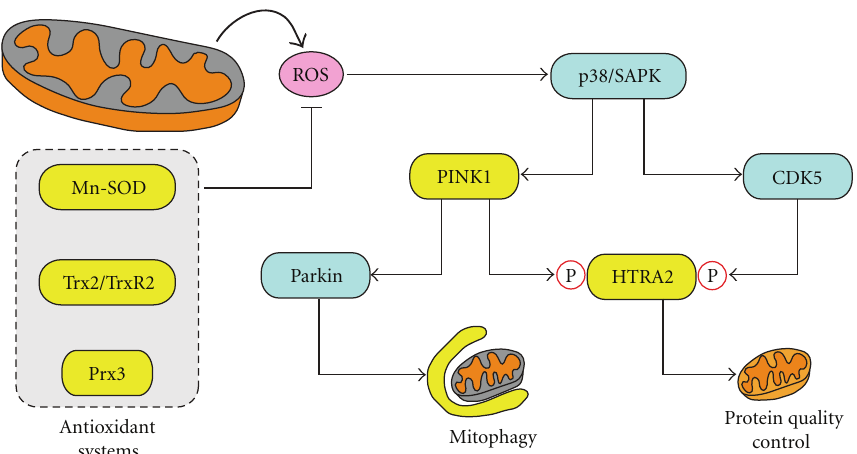
Figure 2: Modulation of mitochondrial quality control by the p38 stress kinase. When mitochondrial stress occurs, ROS production results in the activation of p38. Through its downstream e ff ectors, PINK1 and CDK5, this pathway results in an increase in the proteolytic activity of mitochondrial HTRA2, which in turn contributes to the suppression of mitochondrial damage by enhancing protein quality control. By promoting the recruitment of cytosolic parkin to damaged mitochondria, PINK1 can also contribute to the clearance of these organelles through mitophagy. Antioxidant systems modulate the levels of ROS and can therefore a ff ect signalling from p38 to either PINK1 or CDK5. Yellow: mitochondrial proteins; cyan: cytosolic